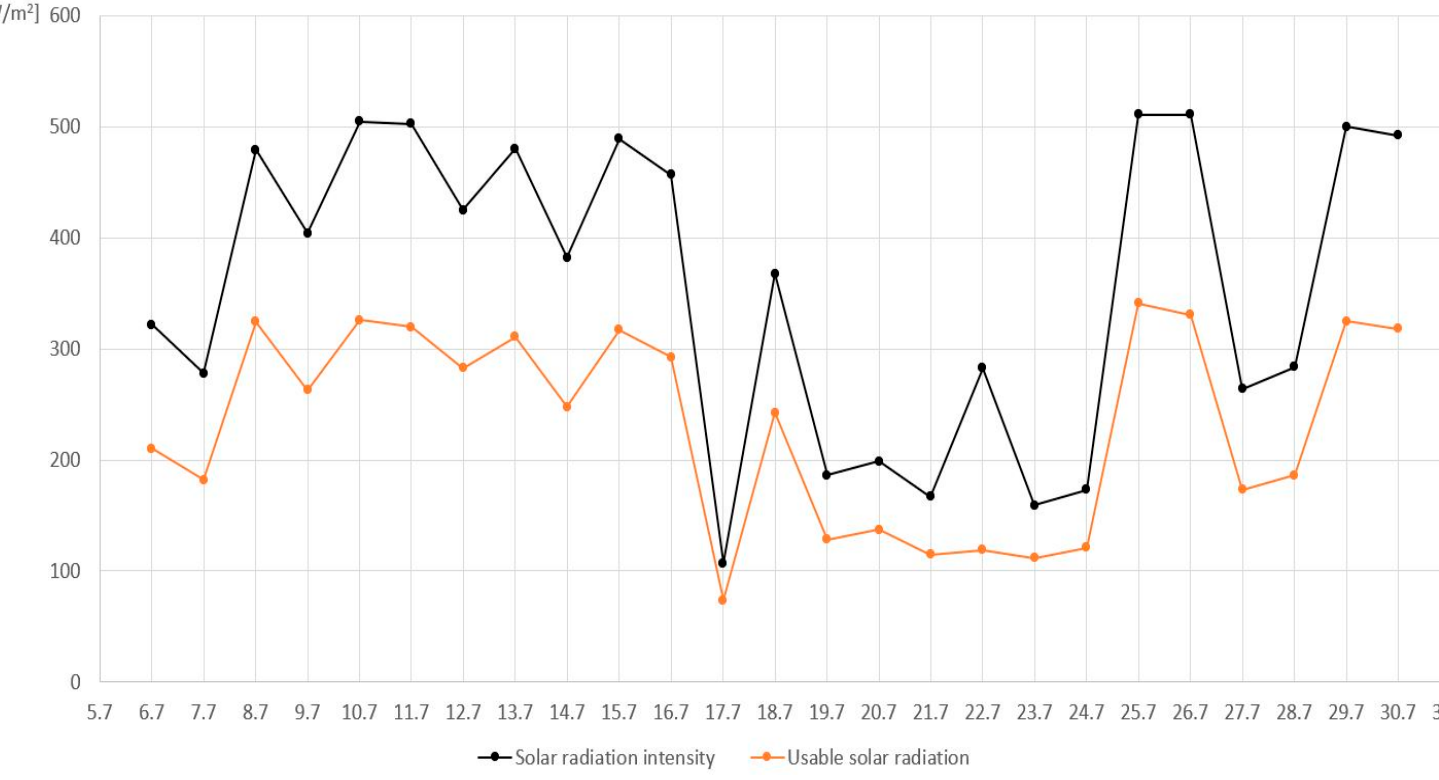
Figure 9. Solar radiation intensity and usable solar radiation.